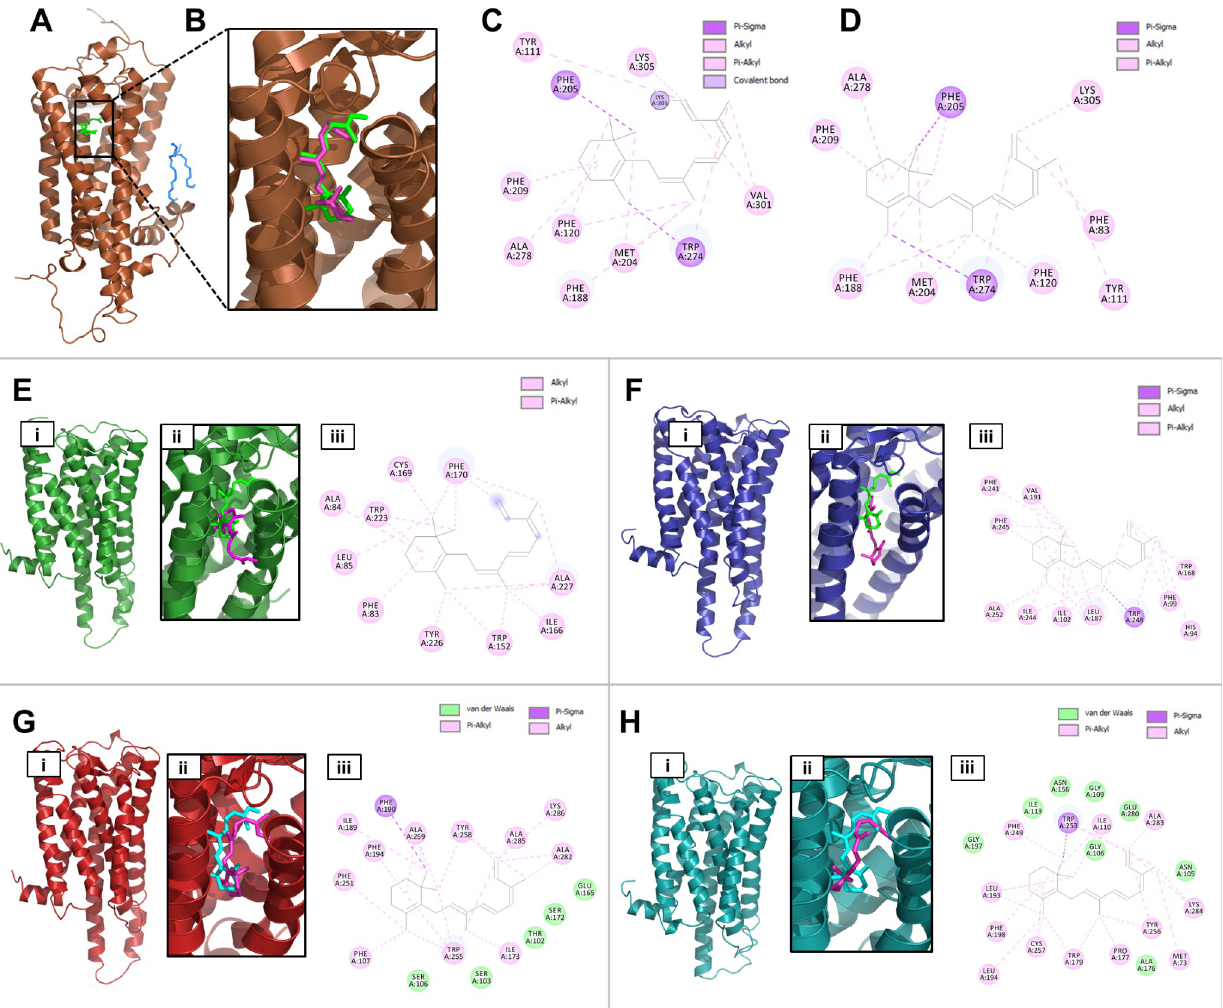
Fig 4. Do the putative coral opsin proteins have a propensity to bind retinal which would make them light sensitive? To address this question, we created homology models and conducted molecular docking of the “rhodopsin” receptors with retinal. (A) Crystal structure of squid rhodopsin (2ZIY). Squid is the evolutionarily closest organism to corals of those for which rhodopsin structures exist. (B) Expanded view of the retinal (shown in green in all structures A-H) in the squid crystal structure shown in (A). As a control, the same retinal was docked to the structure andthe docked conformation is shown in pink. (C, D) Molecular interactions of retinal in the crystal structure vs. docked conformation. (E, F, G, H) Homology modeling and docking studies with coral homology models 629, 2270, 12246 and 19775, respectively. In all cases, panels are labeled as follows: (i) homology model, (ii) retinal confirmations: Squid(green) vs. docking pose in coral opsin (magenta), (iii) molecular interaction of docking pose. Details of interactions and the docking scores are provided in S1 Table